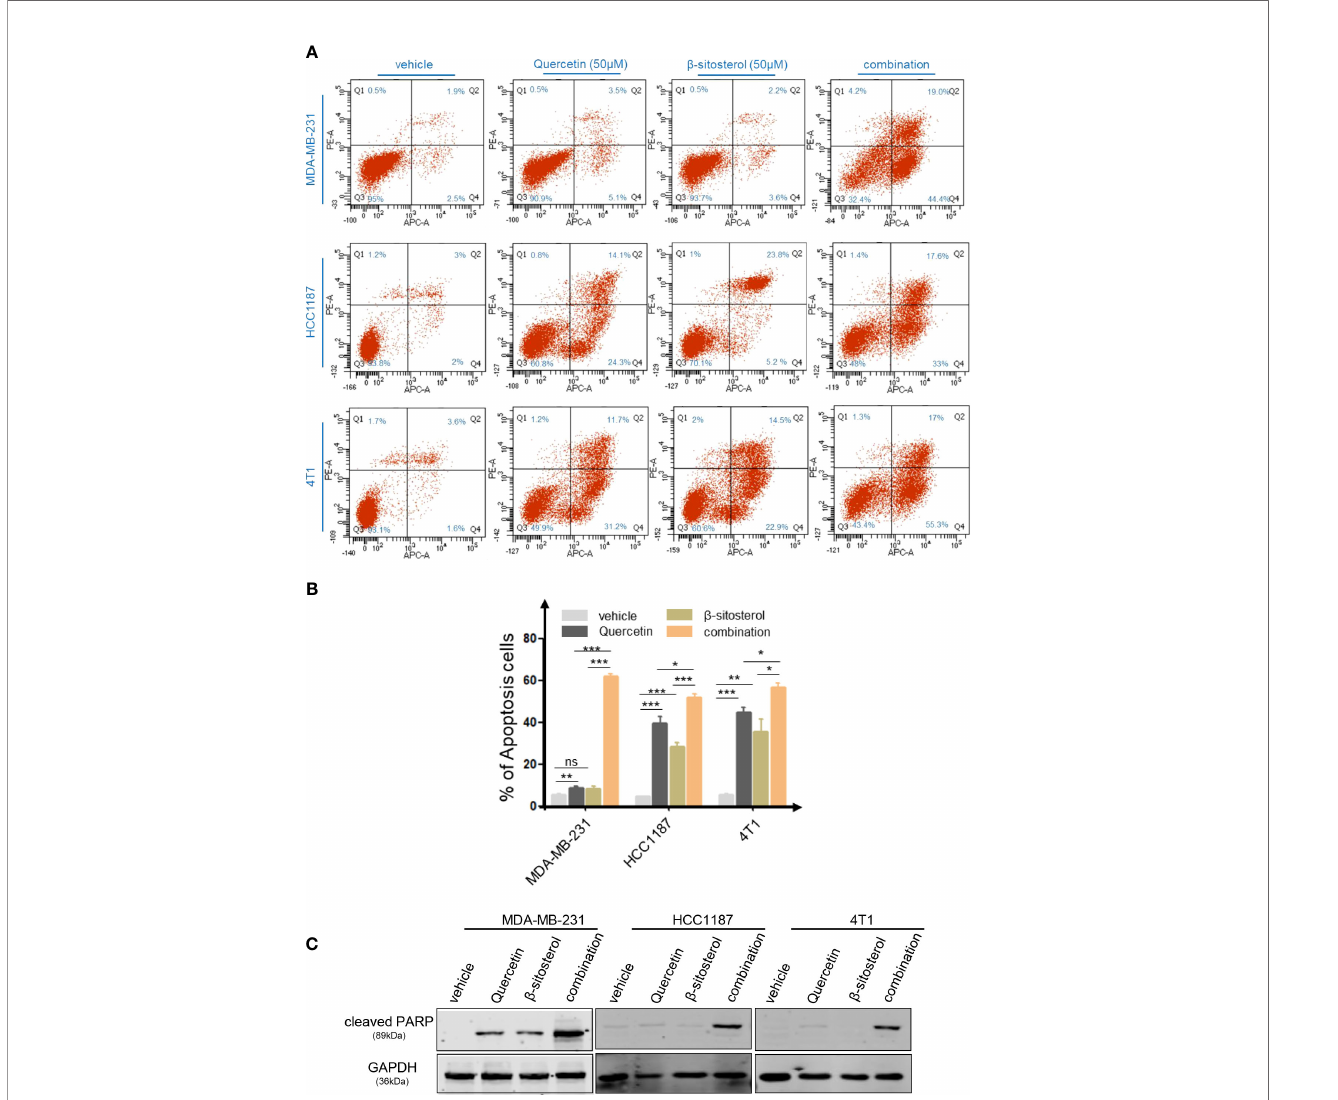
FIGURE 4 | The combo treatment of quercetin and b -sitosterol synergistically increases TNBC cell apoptosis. (A) Apoptotic cell death was assessed by fl ow cytometric analysis following DAPI and FITC-Annexin V staining in cells treated with quercetin and/or b -sitosterol for 48 h. (B) The % of Annexin V+/PI- (early apoptotic cells, lower right), Annexin V+/PI+ (late apoptotic cells, upper right), Annexin V-/PI- (viable cells, lower left), and Annexin V+/PI+ (necrotic cells, upper left) cells are shown. Columns represent the percentages of Annexin V-positive TNBC cells. “ ns, ” not signi fi cant, *P < 0.05, **P < 0.01, ***P < 0.001 (Student ’ s t -test). (C) TNBC cells were treated with quercetin and/or b -sitosterol for 24 h and then subjected to an immunoblotting